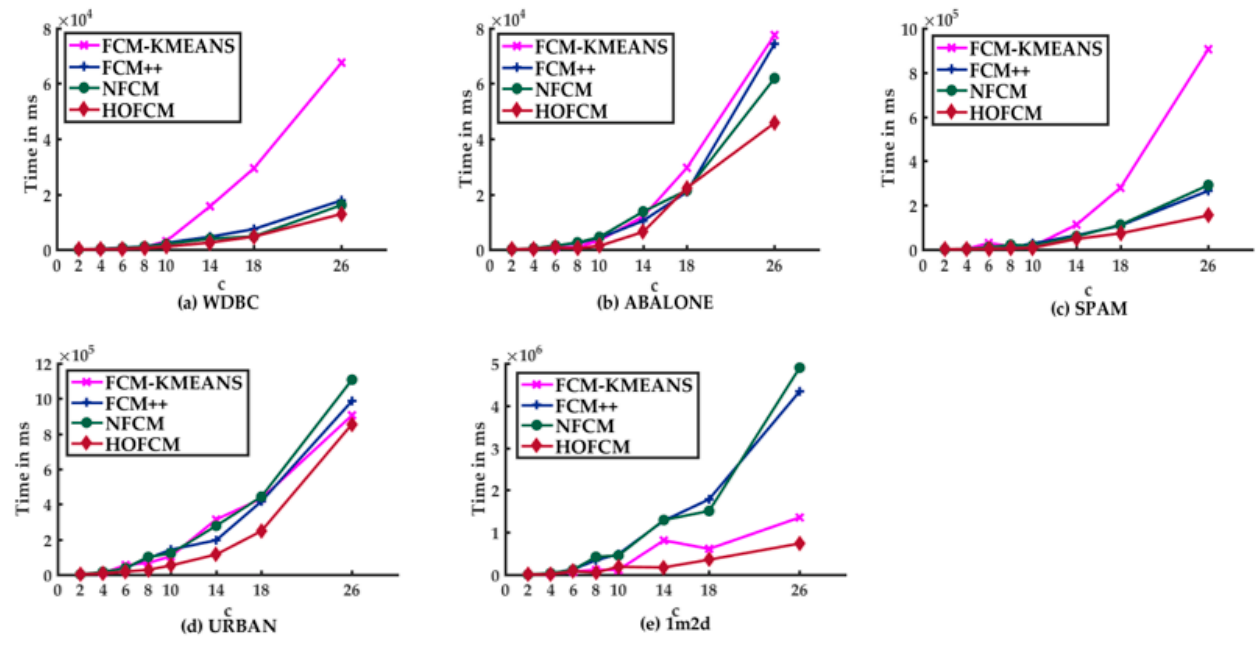
Figure 5. The behavior of datasets in Experiment II.